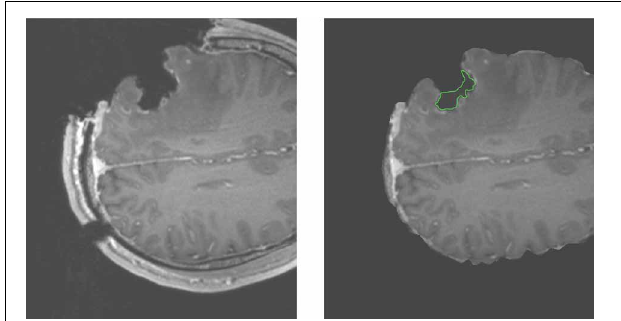
the green demarcated region near the edges of the tumor cavity.